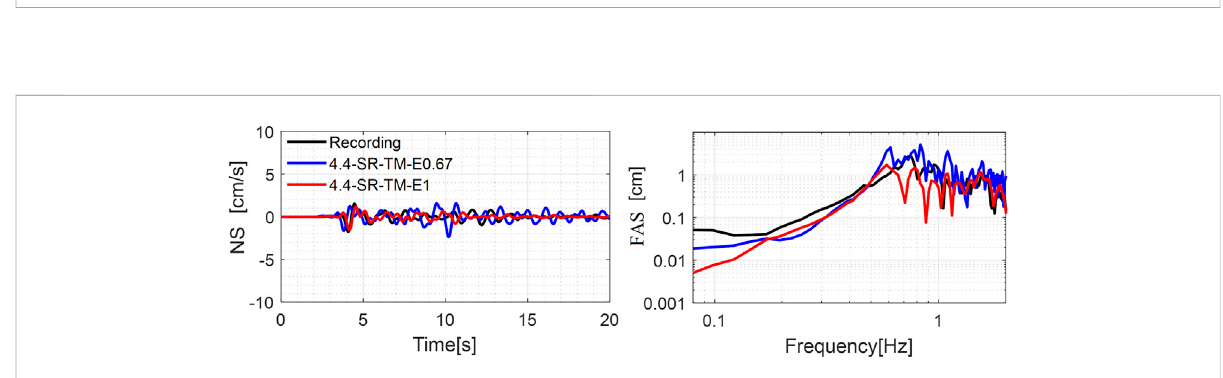
FIGURE 6 Sensitivity of results to the velocity models: 6.5-HR-T-E (black), 6.5-SR-T-E (blue) and 6.5-SR-TM-E (red). (A) Map indicating the location of receivers Aand Band theslipdistribution ofthe1978 earthquake. (B – C) Comparisonofvelocitytime histories and FAScomputed atreceiver A andB from the three models under